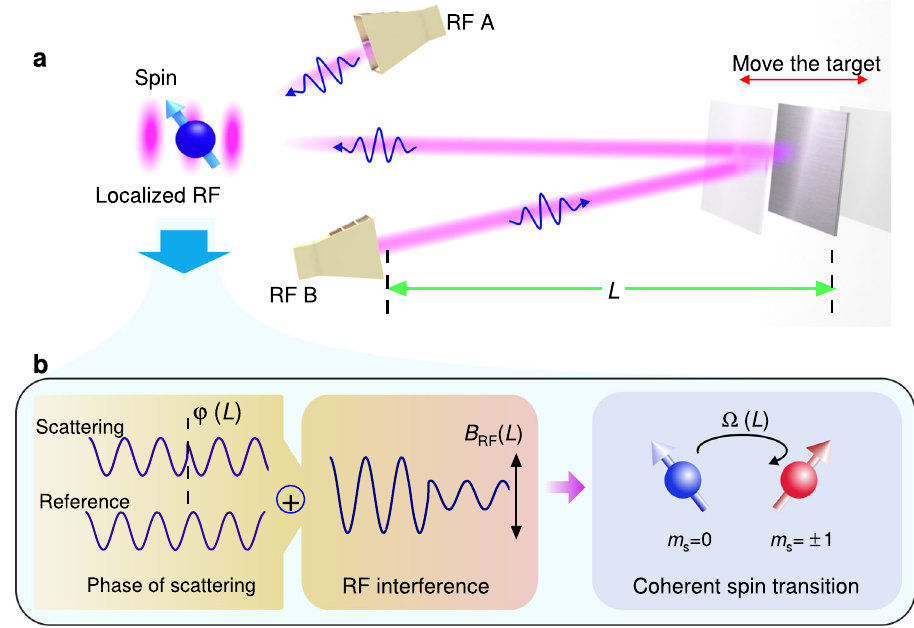
Fig. 1 | The scheme of high accuracy RF ranging with a quantum sensor. a Conceptual setup for the radio ranging with quantum sensor. Two RF paths with the same frequency serve as the reference (RF A) and ranging signal (RF B). The ranging signal is re fl ected by a target with a distance of L . Then, the free space interference signal between the two paths is con fi ned in a microscale volume and interacts with the NV center quantum sensor. b Principle of extracting the target ’ s